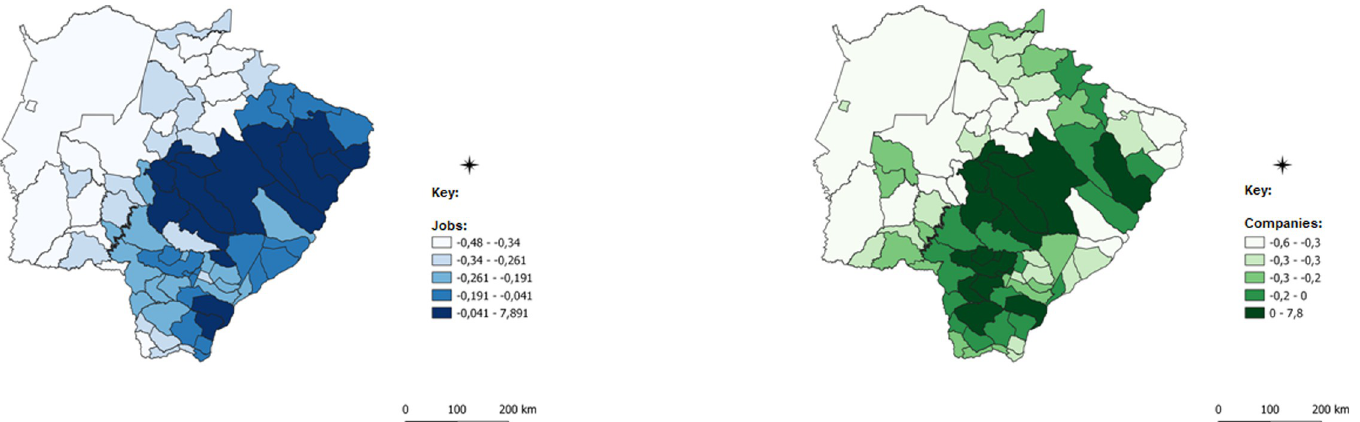
PLOS ONE | https://doi.org/10.1371/journal.pone.0284023 April 7,